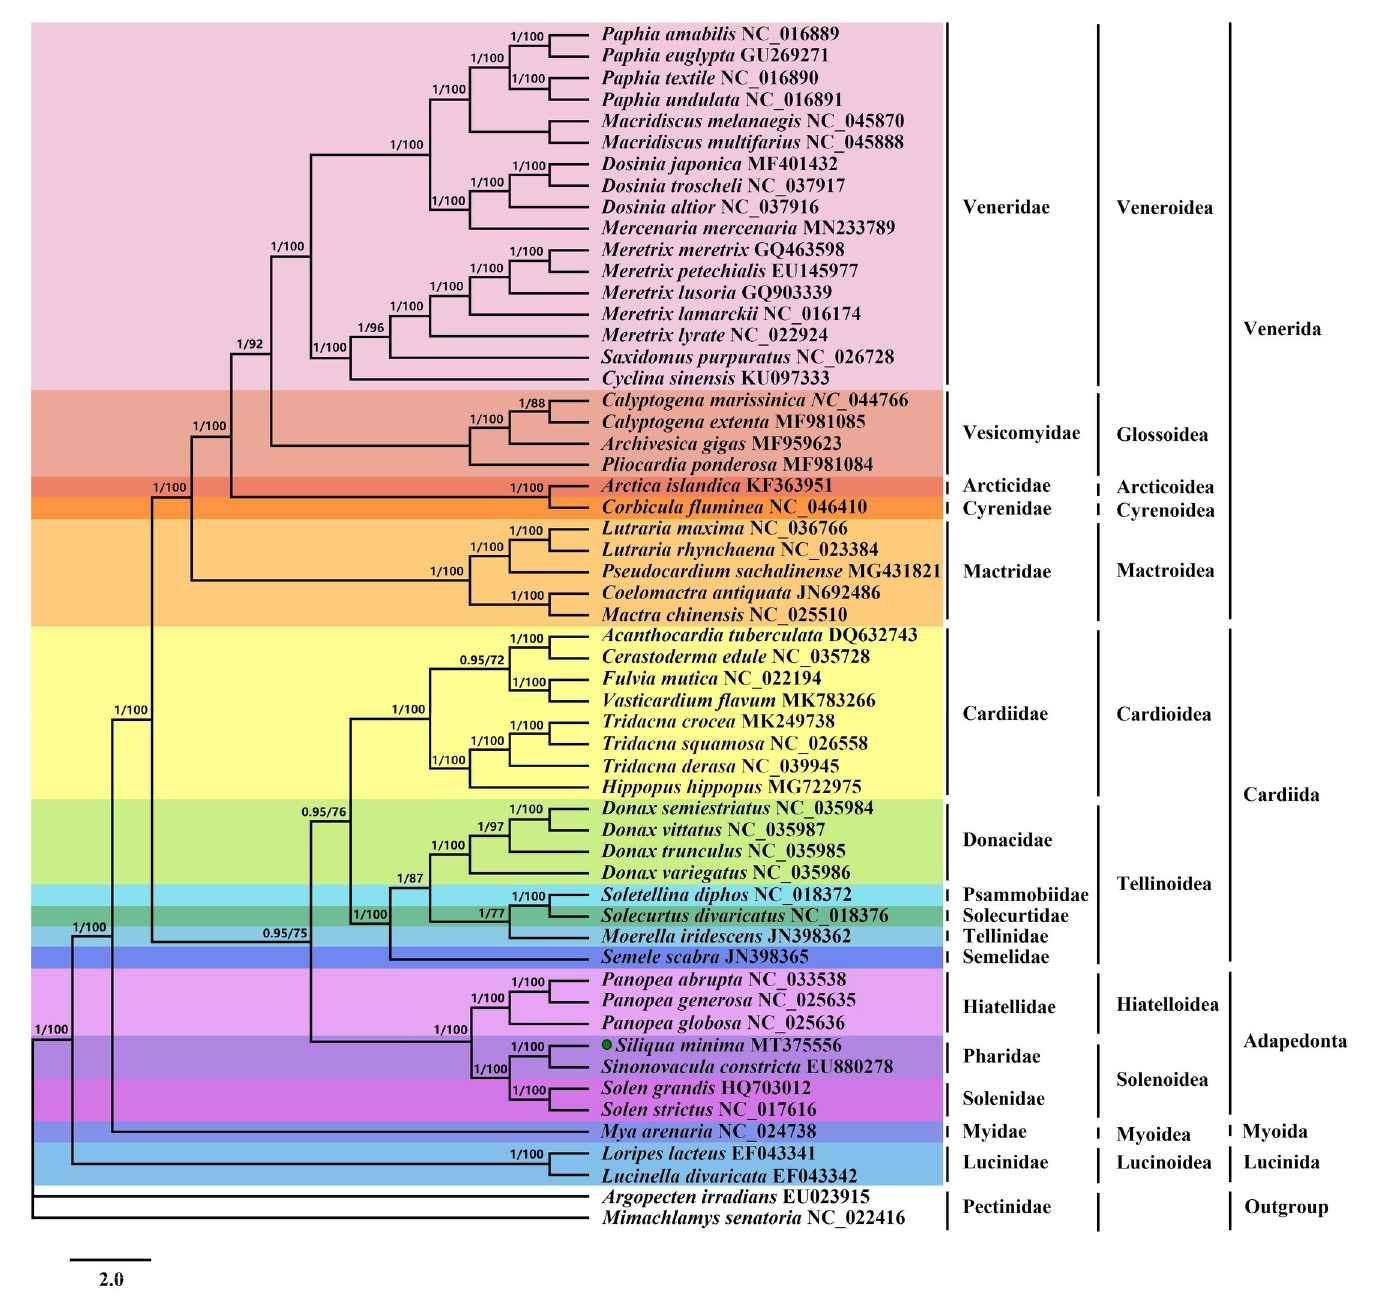
Fig 8. The phylogenetic tree for S . minima and other Bivalvia species based on 12 PCGs. Phylogenetic tree inferred using Bayesian inference (BI) and maximum likelihood (ML) methods, the PP value is in front of the node. the value on the left side of the slash is the posterior probabilities estimated by Bayesian tree, and the value on the right side is the maximum likelihood tree. The green dot indicates S . minima in this